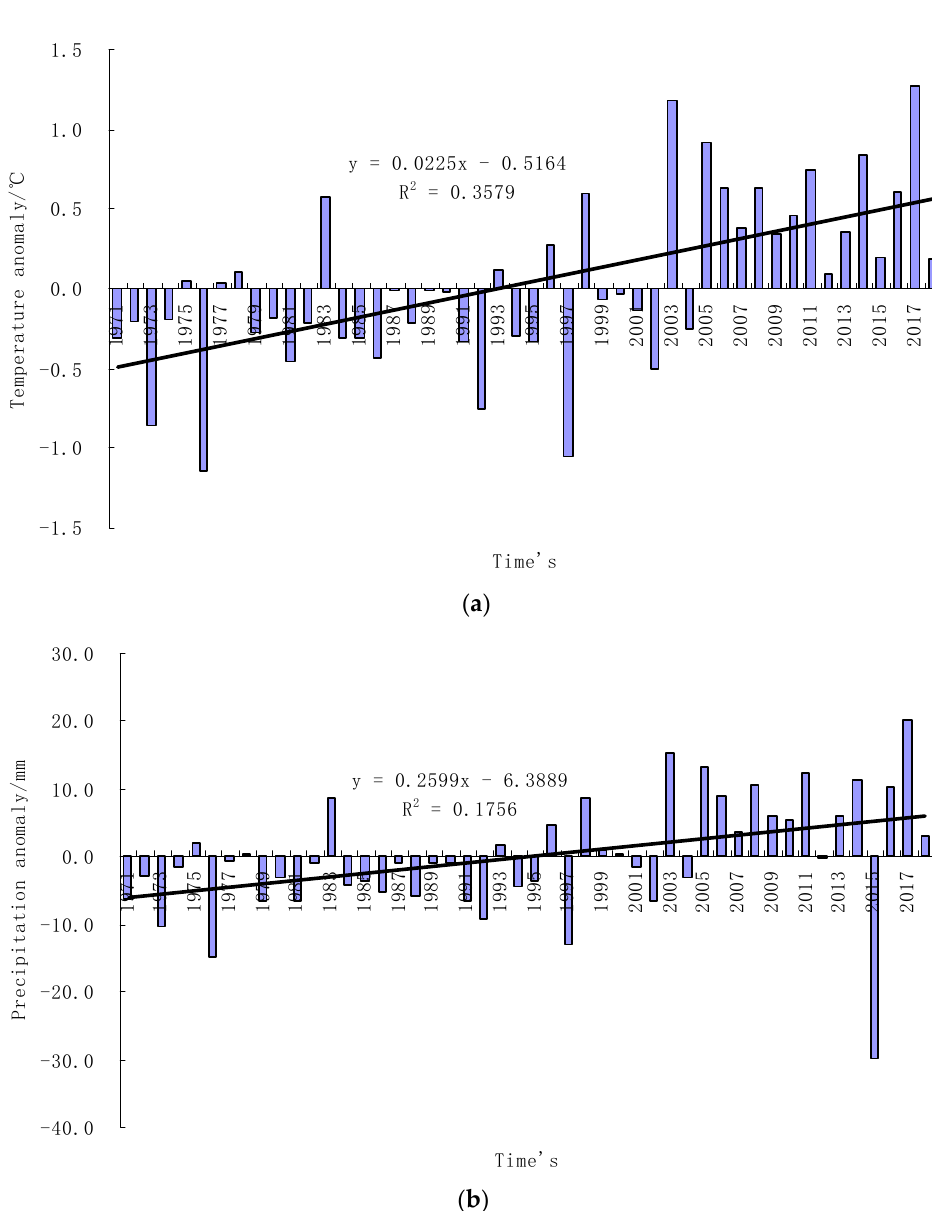
Figure 5. M-K test of the trends of annual precipitation changes during the summer and autumn seasons in Fujian from 1971 to 2018.